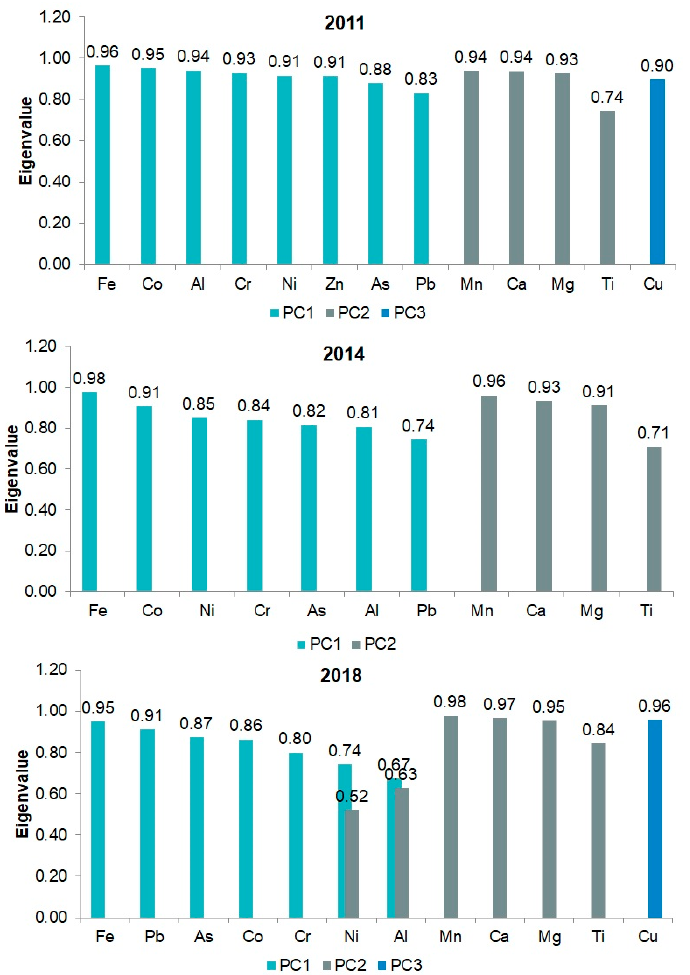
Figure 7. The loadings of analysed elements in different component groups after principal component analysis (Varimax rotation) in beach sediments of south-eastern Baltic Sea coast (Lithuania) in 2011, 2014, and 2018.